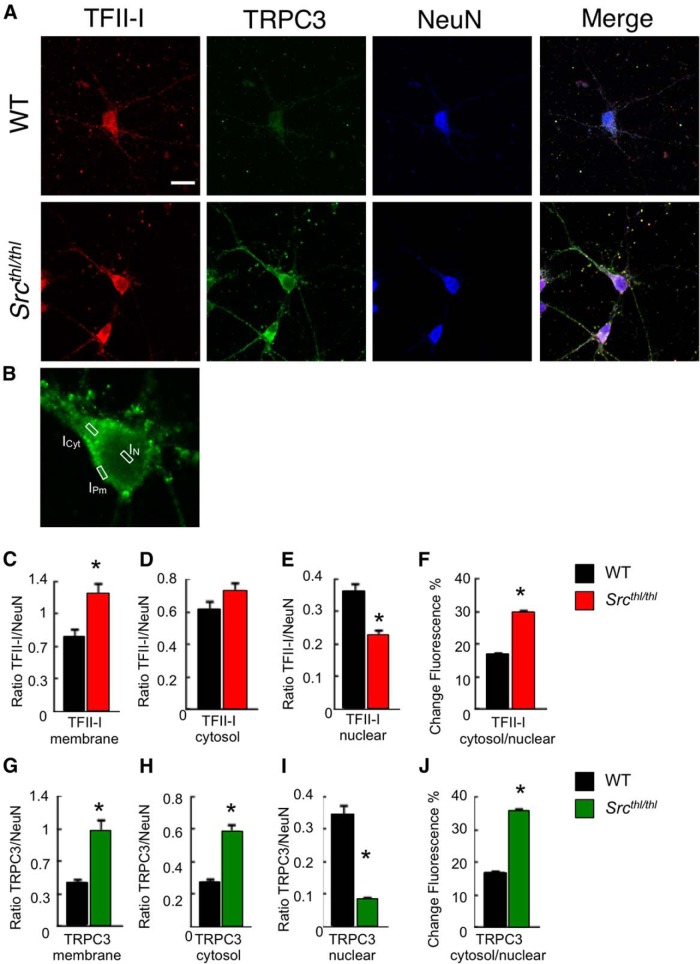
Altered cellular localization of TRPC3 and TFII-I in cultured cortical neurons. TFII-I and TRPC3 fluorescence intensity was calculated from pooled data derived from two independent experiments, each using 10 pups from two different litters (n = 60). A, DIV6 cortical neurons were labeled for TFII-I in red, TRPC3 in green, and NeuN in blue. Scale bar is shown in the first panel, WT TFII-I, 40 μm. B, TFII-I, TRPC3, and NeuN fluorescence intensity was measured in the nucleus (IN), cytosol (ICyt) and plasma membrane (IPm). Fluorescence intensity was measured in a single section in the middle of the entire Z-stack for every neuron imaged. Scale bar, 5 μm. C, Srcthl/thl mice had higher levels of TFII-I in the membrane than WT littermates. D, There was no significant differential expression of TFII-I in the cytosol. E, WT mice showed higher levels of TFII-I in the nucleus compared to Srcthl/thl littermates. F, The 30% difference in TFII-I levels between the cytoplasm and nucleus in Srcthl/thl mice and 17% difference in WT mice shows that TFII-I was more evenly distributed throughout the cell in WT mice. G, Srcthl/thl mice had higher levels of TRPC3 in the membrane than WT littermates. H, Srcthl/thl mice had less TRPC3 in the cytosol than WT littermates. I, Srcthl/thl mice had less TRPC3 in the nucleus compared to WT littermates. J, There was a 36% difference in TRPC3 levels between the cytosol and the nucleus in Srcthl/thl mice. In WT mice, there was only a 17% difference of fluorescence, which means that TRPC3 was more evenly distributed throughout the cell in WT mice. Data are expressed as mean ± SEM, *p < 0.05.